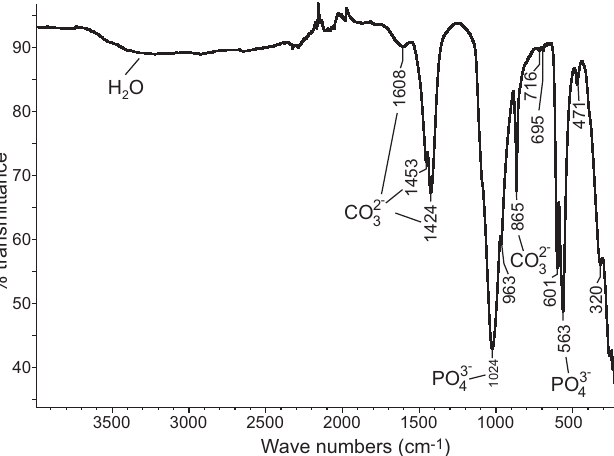
Fig. 7. Representitave ATR-FTIR spectrum of Sphenothallus aff. longissi- mus from Viivikonna Formation, Kivõli, NE